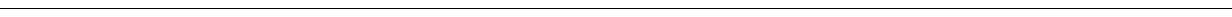
Fig. 1 Discovery of new proteins localized to the apical complex in T . gondii . a Comparisons for known proteins previously localized to the apical complex (left), new hypothetical proteins predicted (middle), and proteins identi fi ed to be at the apical complex (right). Patterns based on expression pattern during the cell cycle 49 . Known proteins included: RNG1 19 , RNG2 20 , AKMT 50 , MyoH 11 , CaM1, CaM2, CaM3 23 , MLC3, MLC5, MLC7 11 , SAS6L 39 . b Work fl ow used for identi fi cation, con fi rmation, and functional analysis of new apical proteins with protein numbers shown at each step. a , b See also Supplementary Table 1 and Supplementary Figs. 1, 2. c Super-resolution imaging of the essential protein CPH1 at the conoid. IFA was performed with mouse anti-Ty (green), rat anti-HA (red), and rabbit anti-MLC1 (blue) followed by secondary antibodies conjugated to Alexa Fluor dyes. Scale bar = 1 µ m. d Localization of CPH1 at the apical complex by immunoelectron microscopy. Red arrows indicate distribution of gold particles along the microtubules. Scale bar = 100 nm. c , d Extracellular parasites were stimulated with 3 μ m A23187 for 10 min to extend the conoid prior to processing. Images are representative of three or more experiments with similar outcomes. e Conservation of CPH1 and the apical complex in apicomplexan parasites. CPH1 orthologs (Supplementary Table 1 lists genes and species names) were used to generate the dendrogram shown (left). The chart summarizes the presence (+) and absence ( − ) of the conoid or polar ring 2 and ankyrin repeats in CPH1 (present